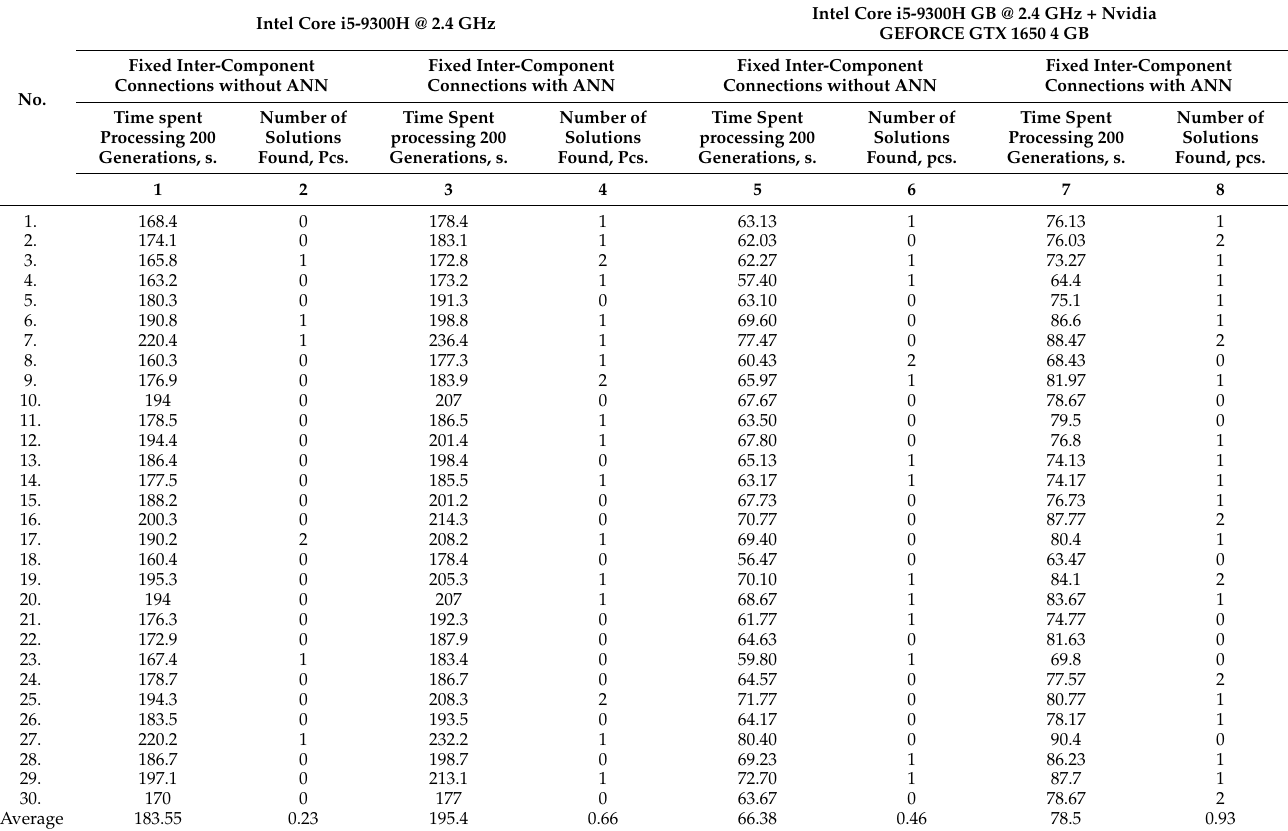
Table 11. Computational experiment